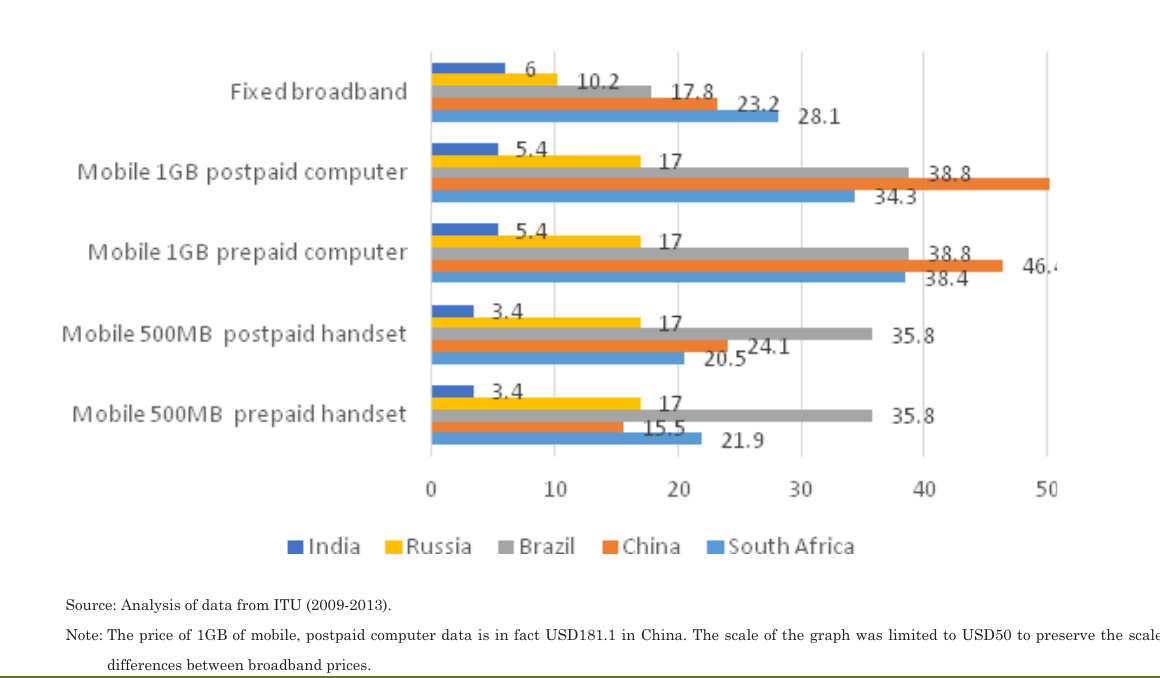
FIGURE 4: BROADBAND PRICE COMPARISONS (USD, MONTHLY BASKET) (ITU, 2012)